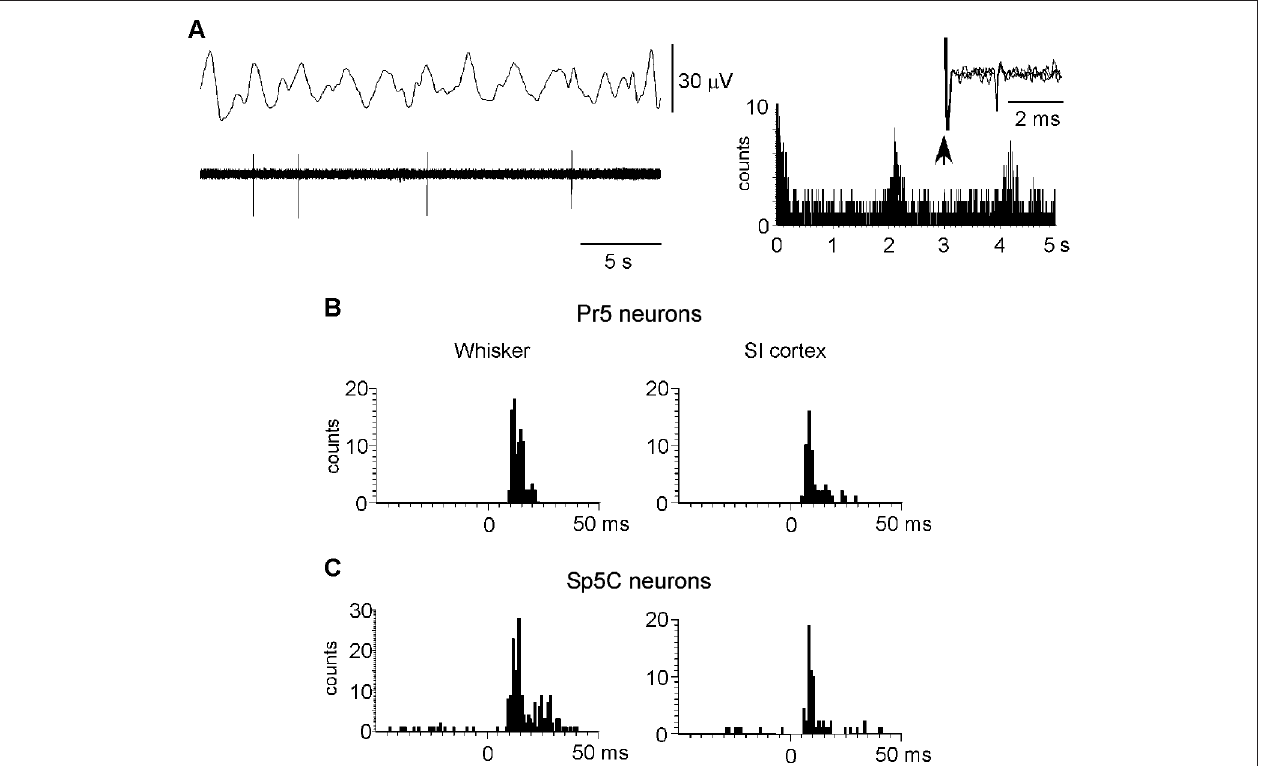
VPM electrical stimulation induced antidromic spikes (three traces are superimposed). (B) PSTHs of responses evoked by whisker stimulation or S1 cortex stimulation (left and right histograms, respectively) in a representative Pr5 neuron. (C) same PSTHs in a Sp5C neuron. PSTHs are the sum of 30